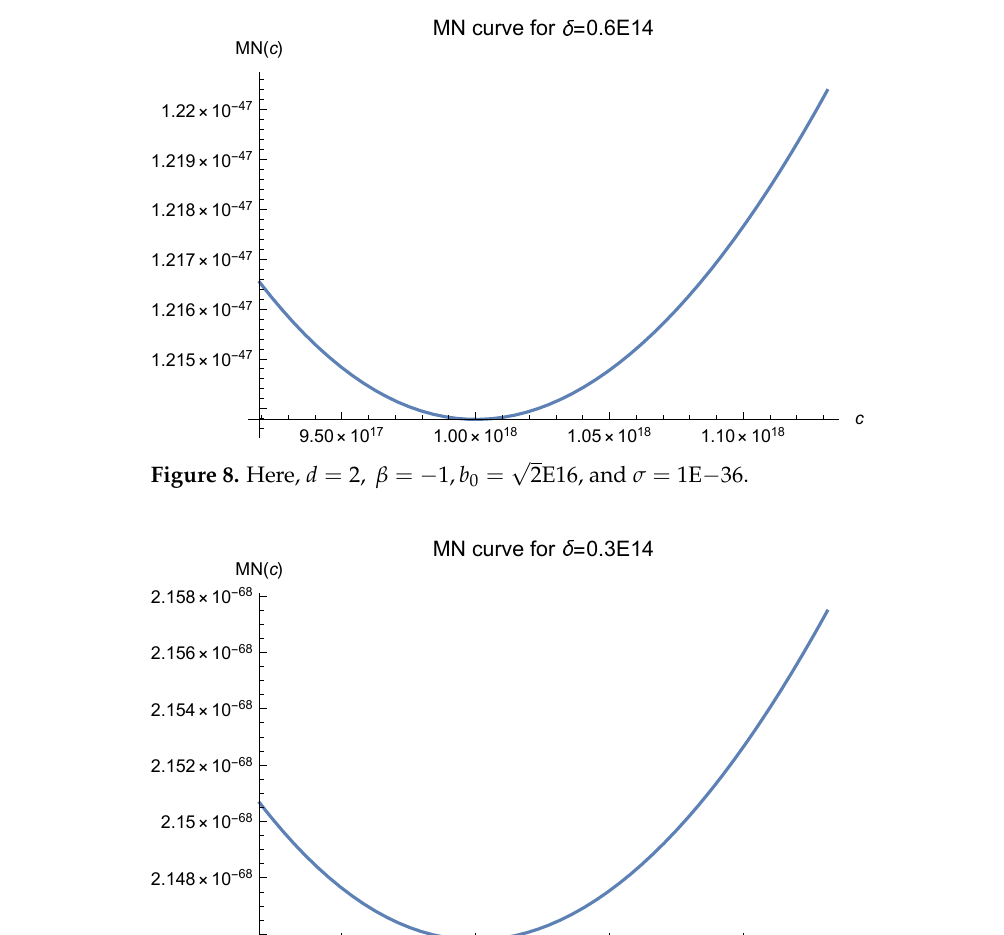
√ 2E16, and σ = 1E − 36. MN curve for = 0.1E14 (cid:1)